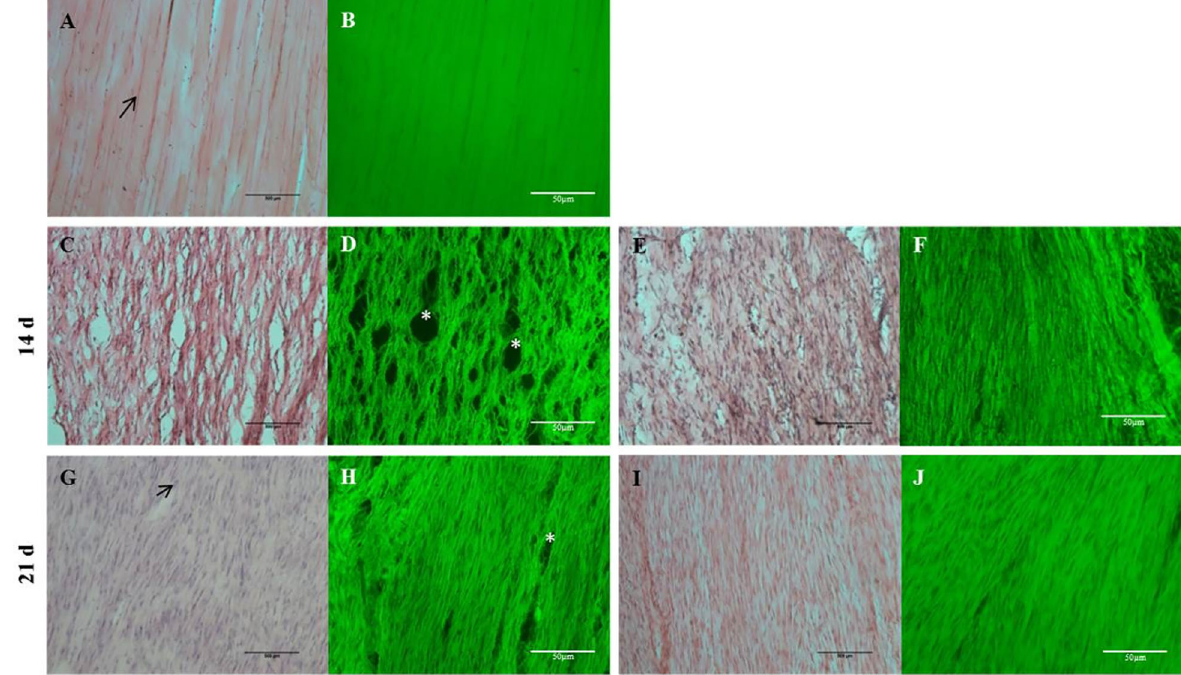
Figure 1. Hematoxylin-eosin staining and fl uorescence microscopy (green) of longitudinal sections of rat Achilles tendon at 14 and 21 days post-surgery. Control group ( A and B ), vehicle group analyzed at 14 ( C and D ) and 21 days post-surgery ( G and H ), and ascorbic acid group analyzed at 14 ( E and F ) and 21 days post-surgery ( I and J ) are shown. *Tissue holes. Scale bar, 50 m